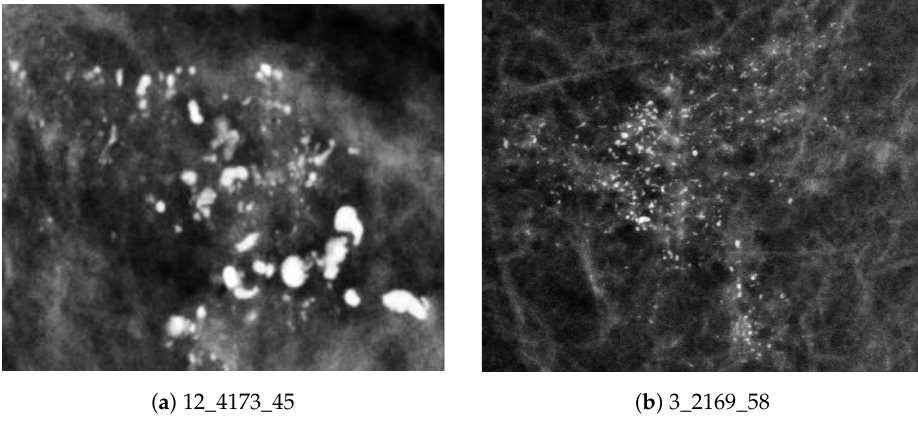
Figure 1. Example MC clusters from the OMI-DB database: ( a ) benign MC cluster; and ( b ) malignant MC